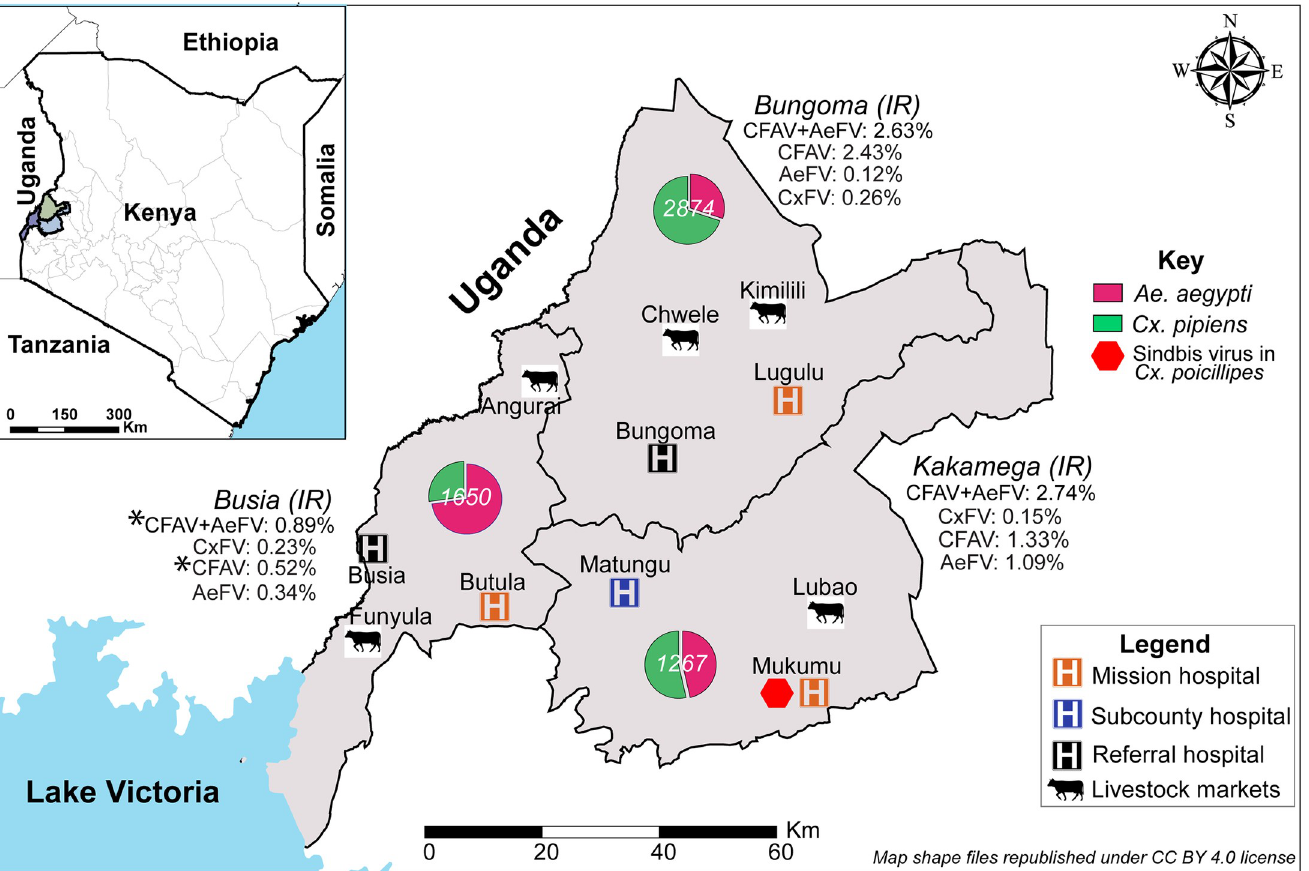
Fig 1. Sites where mosquito traps were set in the three counties in western Kenya. Pie charts of the relative abundance of Ae . aegypti and Cx . pipiens s.l. and their infection rates (IRs) with cell fusing agent virus (CFAV)/Aedes flavivirus (AeFV) and Culex flavivirus (CxFV), respectively, are shown for each county. Infection rates that were significantly lower in Busia than in the other two counties are indicated by asterisks. Water bodies, country and county boundary data were downloaded and re-published under CC BY 4.0 license from the World Resources Institute website (https://www.wri.org/resources/data_sets) [19]. The map was developed using